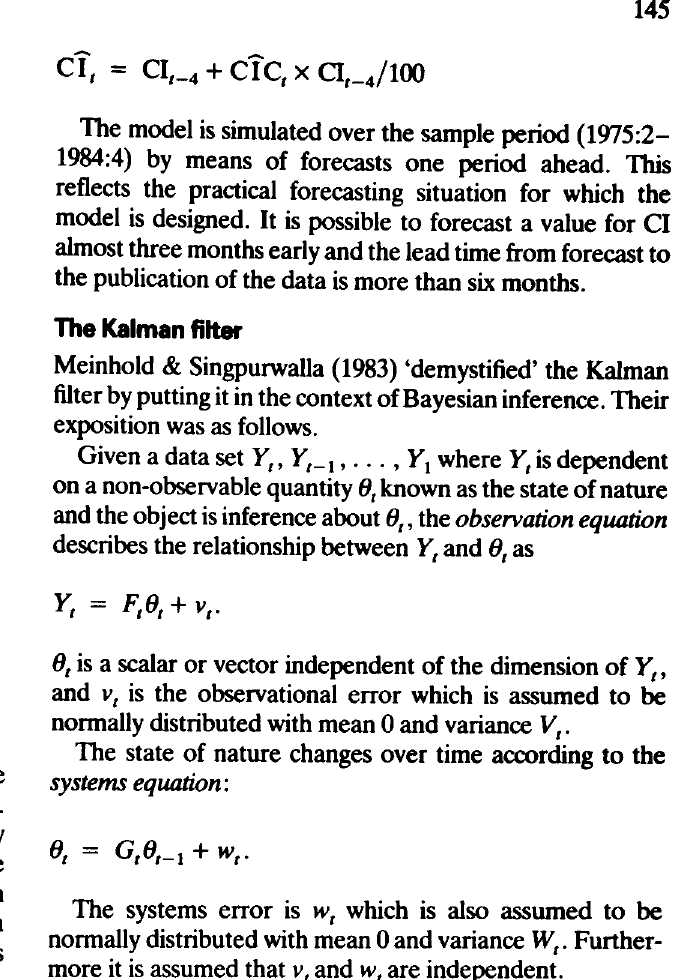
Rotated factor matrix Factor